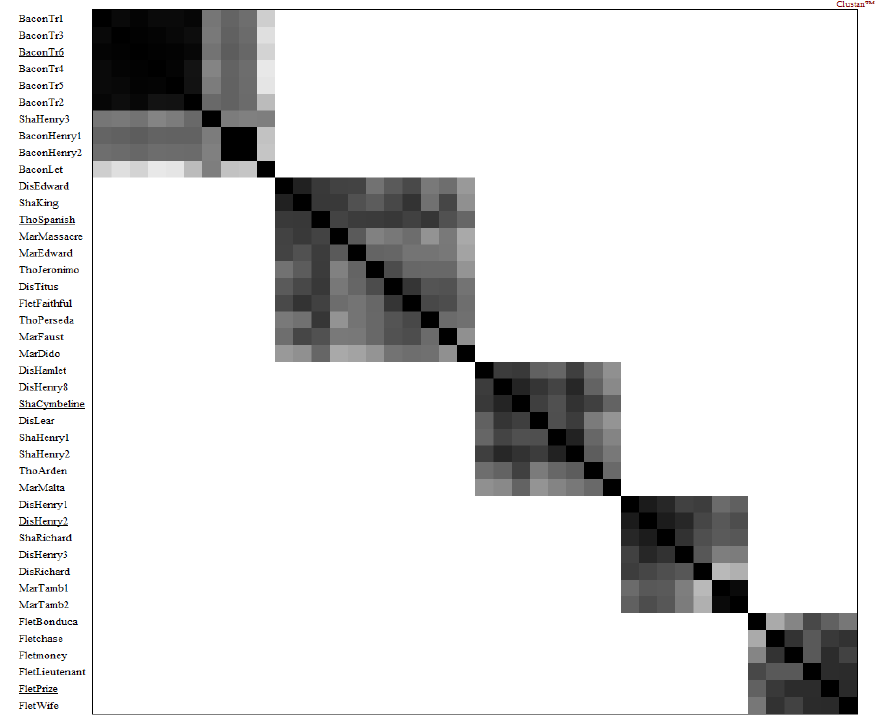
Figure 10. An assessment of clustering tendency test for D FW